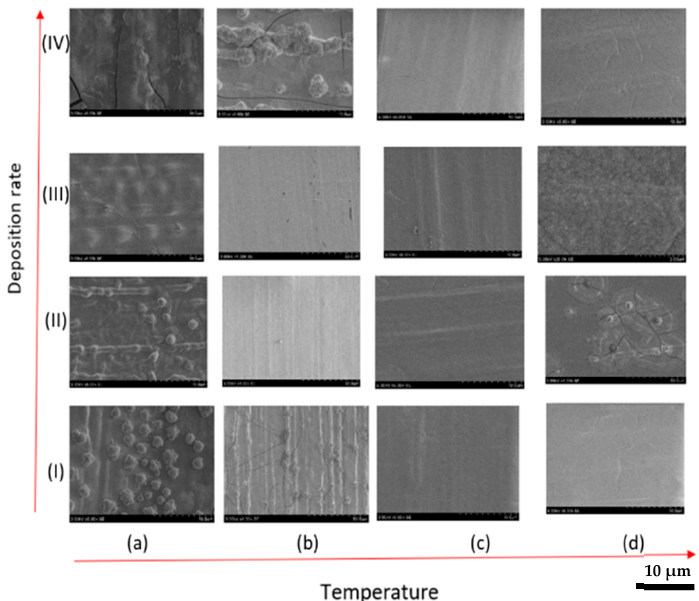
Figure 1. SEM of BCO thin films (×5 k magnification) on glass sealing alloy substrate at different temperatures (20 °C ( a ), 150 °C ( b ), 450 °C ( c ), 600 °C ( d )) and deposition rates (2 Å/s (I), 4 Å/s (II), 8 Å/s (III), 12 Å/s (IV)).